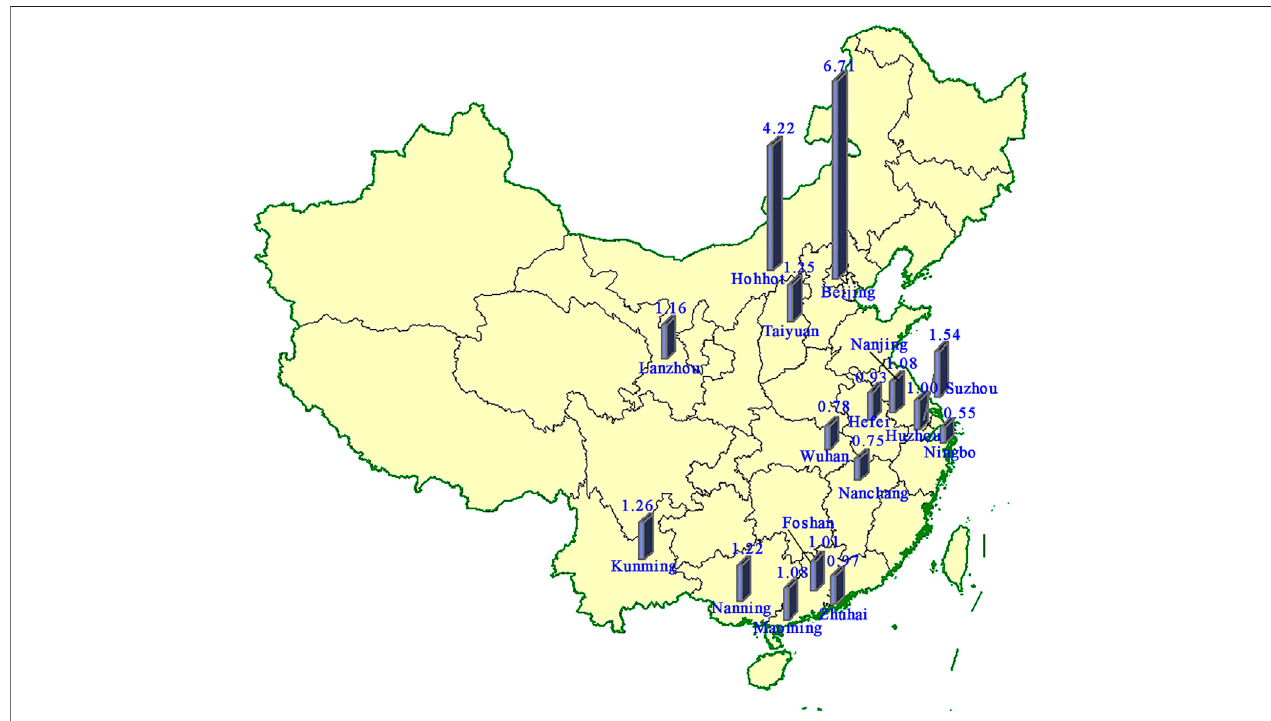
FIGURE 1 | Total Hg concentrations in sewage sludge of 16 Chinese cities. The number on top of each bar represents the mean THg (mg/kg, dry weight) of that city. Mean THg values for individual WWTPs can be found in Supplementary Table S1 .